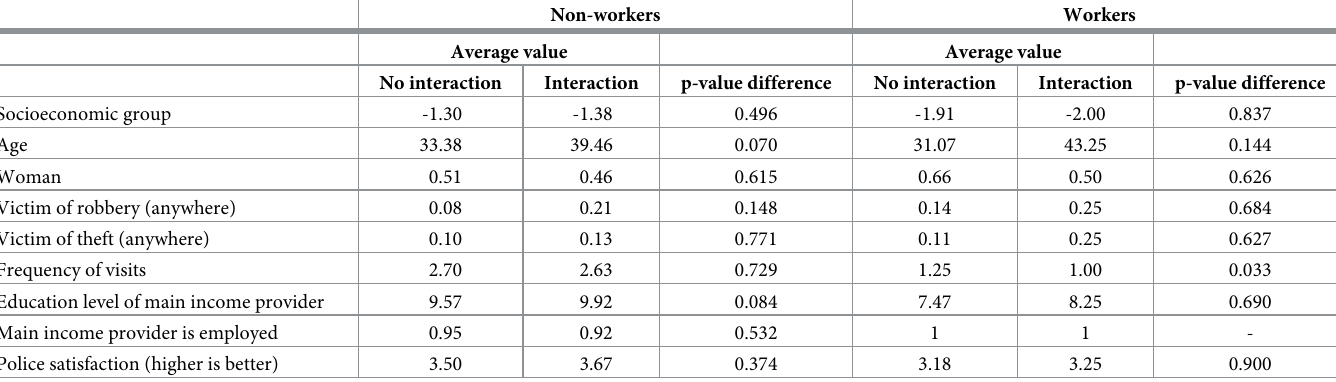
results for non-workers and workers separately. For the whole sample, the only significant difference is in age (those who interacted with similar difference in ages and a slight difference in the education of the household’s main Table 5. Differences in observable characteristics according to interaction with the